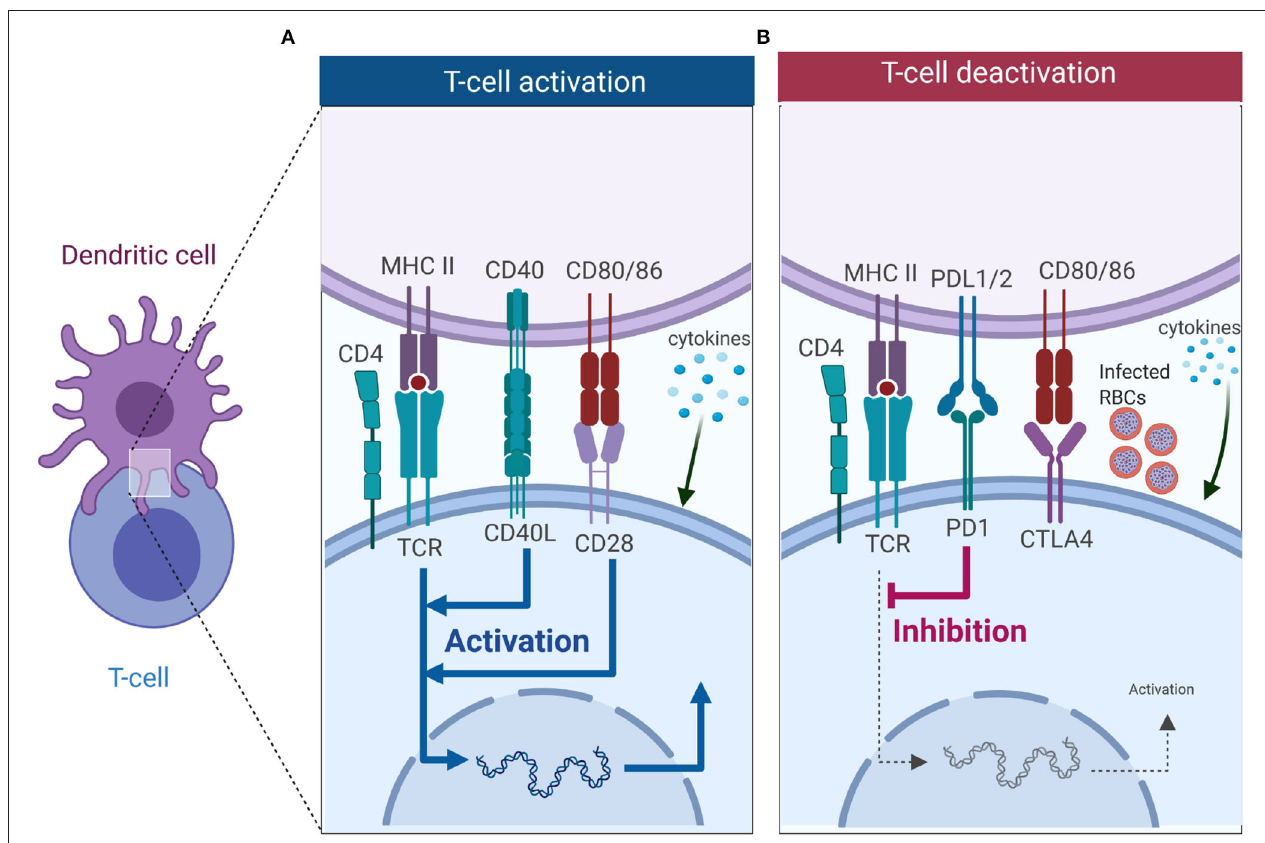
FIGURE 2 | T cell activation or deactivation requires three signals from DCs. (A) T cell activation requires signal 1 in the form of TCR interacting with antigen-MHC complex which is key in innating downward signaling through ITAMs. Interaction of co-stimulatory molecules (interaction of CD40-CD40L, and CD80/86-CD28) form part of signal 2 as they work in tandem with TCR-antigen-MHC complex to enhance TCR signaling and initiate T cell proliferation. Signal 3 comes from DCs in the form of cytokines, and in CD4T cells it is key in dictating which subset it will differentiate into. (B) Co-inhibitory molecules also form part of the second signal but unlike co-stimulatory molecules they inhibit TCR signaling, thus dampening immune responses. Interaction of PD-1 with PD-L1 inhibits T cell activation, while CTLA4 competes for binding with CD28 to CD80/86 and successful binding of CTLA4 to CD80/86 nullifies CD28-CD80/86 activation signal. Malaria has been shown to induce expression of PD-1, LAG3 and CTLA-4 on CD4T cells, and this inhibits the activation signal from DCs (Figure was created using